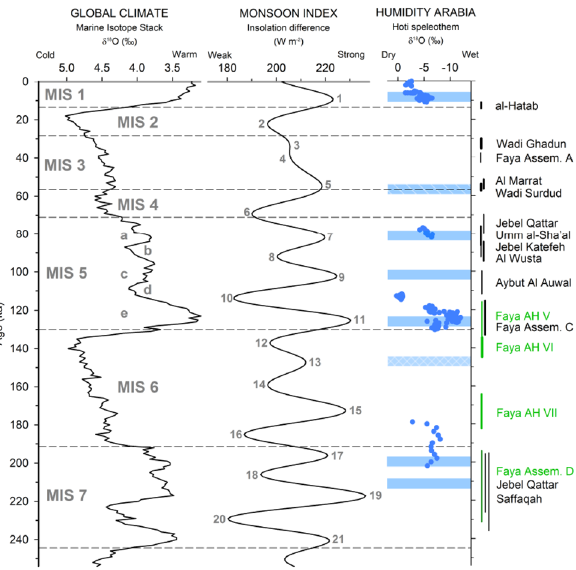
Figure 4. Marine isotope stack as proxy of global climate 56 , the Monsoon Index 43 , speleothem isotope data (blue circles 37 ) as well as phases of lake formation (blue bars 4,6,11,13–15,41,45,47 ) as representation of regional environmental conditions in Arabia. Note the co-occurrence of odd numbered Monsoon Index Peaks (MIP) and the archaeological record. Al-Hatab 32 , Wadi Ghadun 29 , Faya Assemblage A + C 23 , Al Marrat 57 , Wadi Surdud 28 , Jebel Qattar + Jebel Katefeh 25 , Umm al-Sha’al 27 , Al-Wusta 20 , Aybut Al Auwal 24 , Faya AH V–VII + Faya Assemblage D (this paper), Saffaqah 26